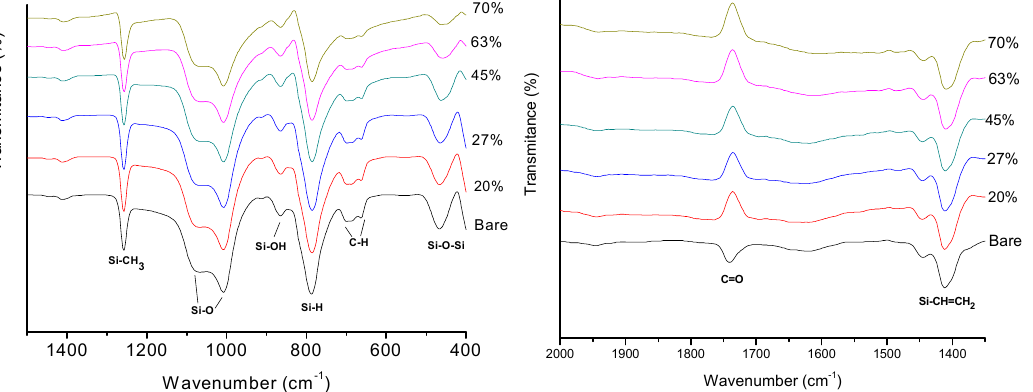
Figure 10. FTIR spectra of anisotropic elastomers of PDMS made with 20%, 27%, 45%, 63% and 70% of CIP ′ s.